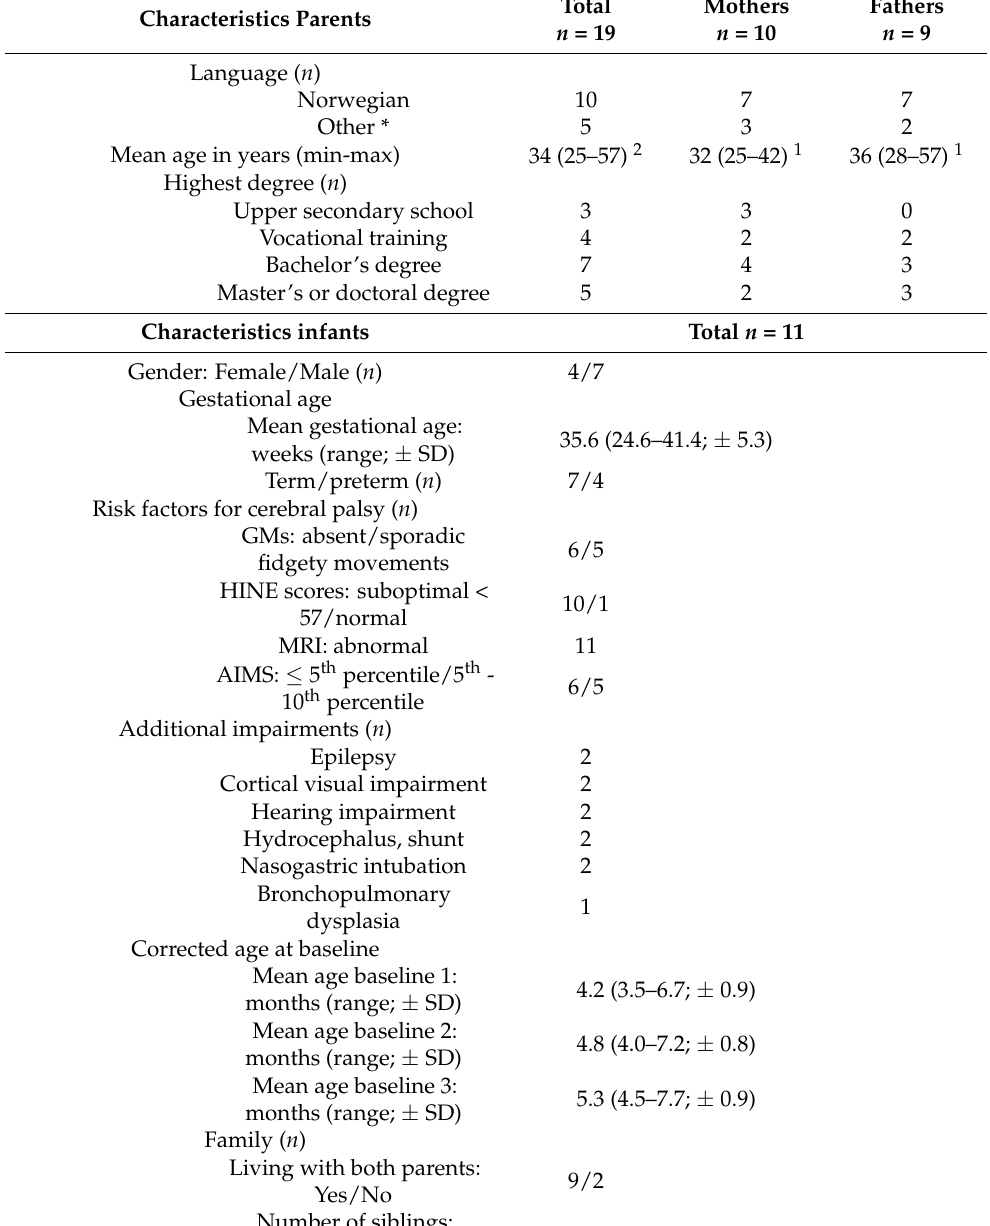
Table 1. Sample characteristics parents ( n = 19) and infants ( n =